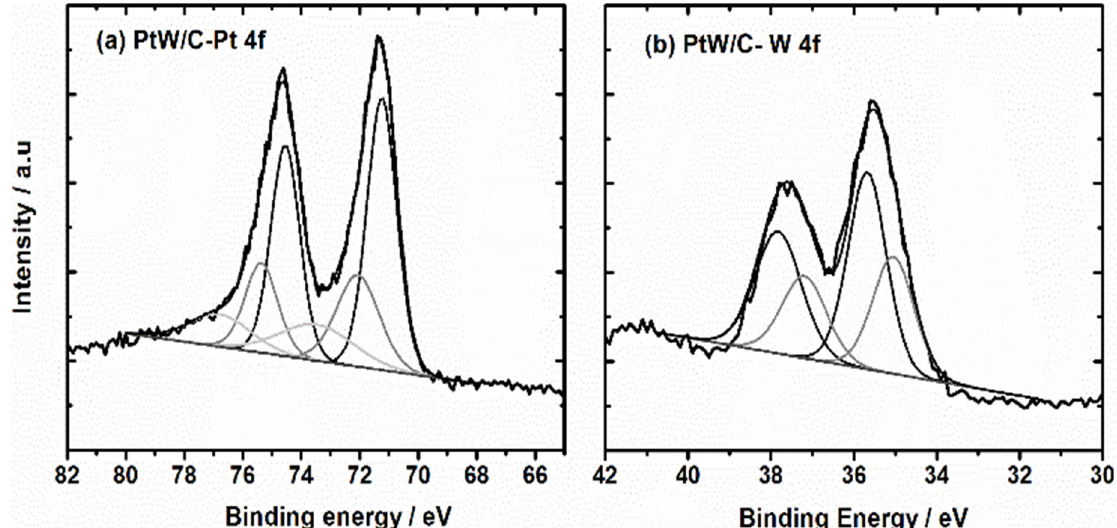
Figure 3 - X-ray photoelectron spectroscopic spectra of carbon supported the PtW/C catalyst in the Pt 4f region ( a ) and W 4f regions ( b ). (Reprinted with permission from Hassan et al.